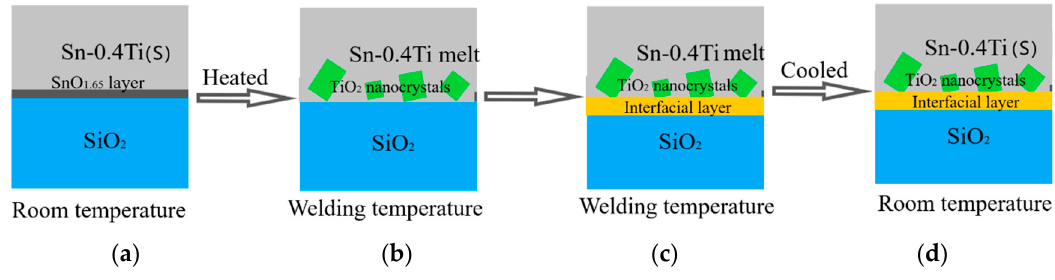
Figure 4. ( a – d ) Schematic diagram of the removed mechanism of SnO 1.65 layer.